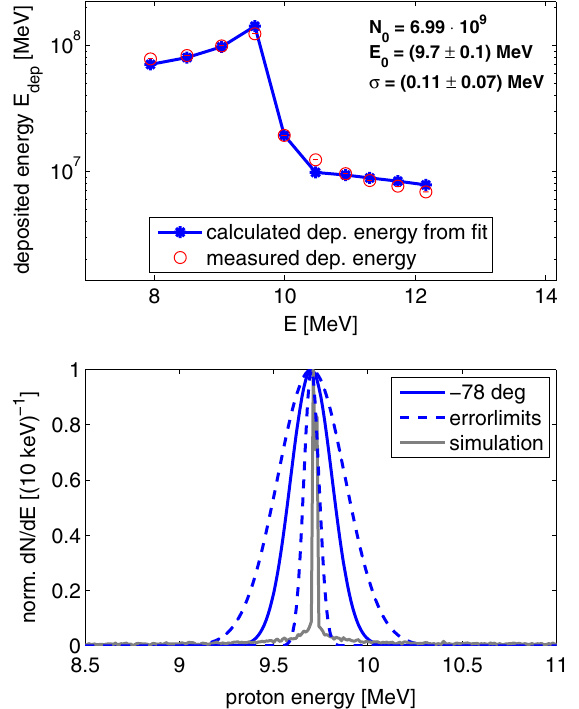
FIG. 5. Shown are the measured deposited energy profile in the RCFs and the calculated one by the fit (upper graph), and the obtained particle spectrum at Φ s ¼ − 78 deg including a simu- lation reference (lower graph).